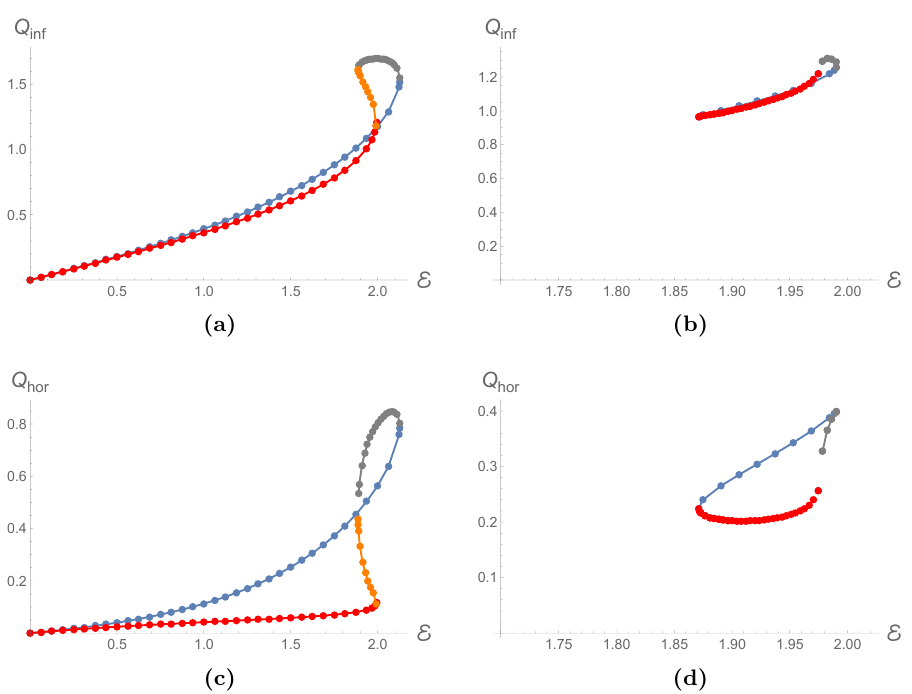
Figure 13. (a){(b) Total charge in one hemisphere at the AdS boundary; (c)-(d) and at the black hole for G N = 1. The (cid:12)rst column is at T = 0 : 275665 and the second at T = 0 : 24179.